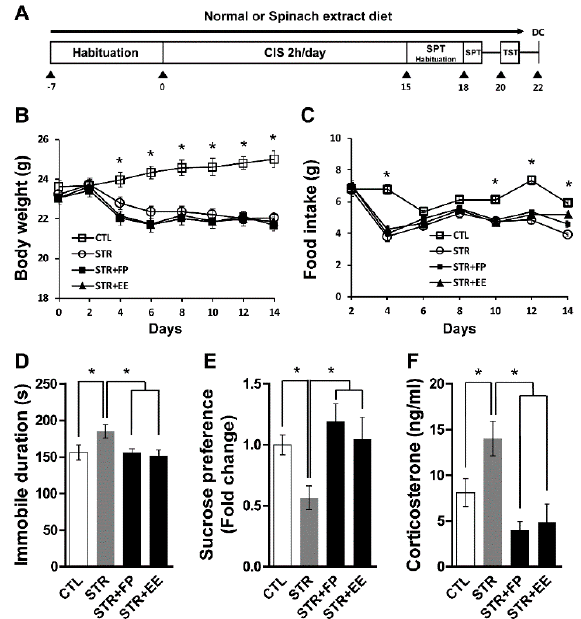
Figure 2. Spinach extract diet attenuated depressive behaviors and increased CORT in a CIS-induced depression model. ( A ) Timeline of CIS experiments. ( B ) Body weight and ( C ) food intake ( n = 7–8 mice per group). ( D ) Immobile duration and ( E ) sucrose preference, assessed by the TST and SPT, respectively (n = 7–8 mice per group). ( F ) Blood CORT level ( n = 4–5 mice per group). All values are means ± standard error of mean (SEM). * p < 0.05. CTL, control; DC, decapitation; EE, ethanol extract; FP, frozen powder; ND, normal diet; STR, stress; CIS, chronic immobilization stress; SPT, sucrose preference test; TST, tail suspension test.